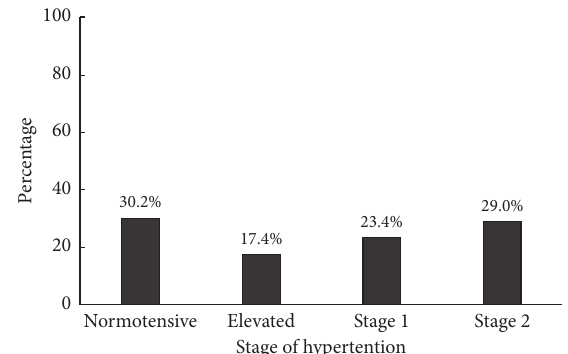
Figure 1: Blood pressure status of bank employees in metropolitan cities of the Amhara Regional State, Ethiopia, 2020 ( n �